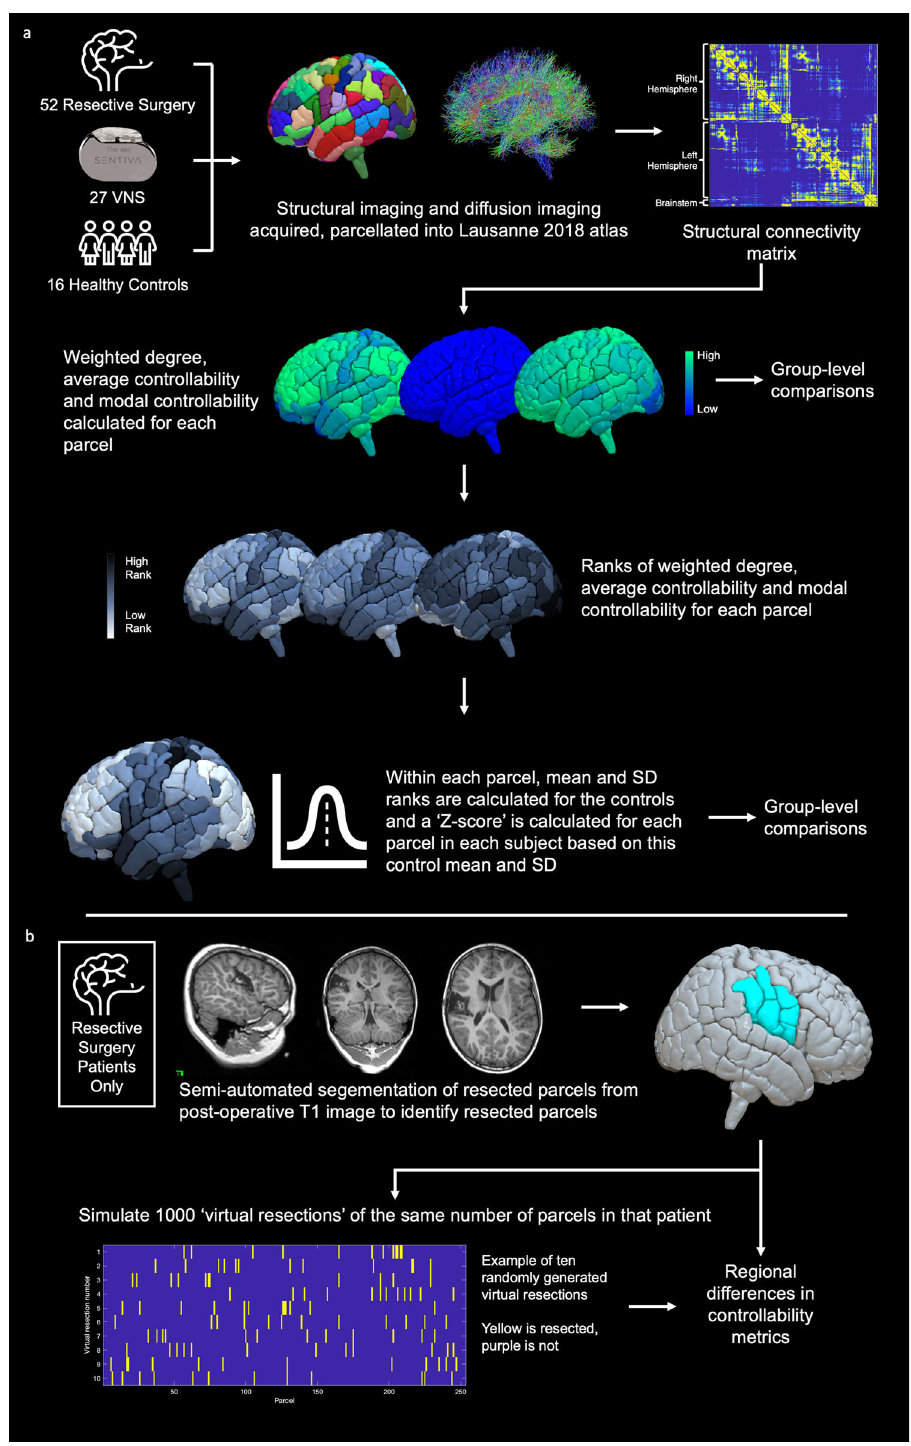
Fig. 7 Summary of image processing work fl ow. a Following subject identi fi cation, structural imaging was parcellated into Scale 3 of the Lausanne 2018 resulting in 253 parcels per patient. Structural connectivity matrices were generated for each patient where the connection strength was derived from the number of streamlines between each of the 253 parcels. Using these matrices, the weighted degree, average controllability and modal controllability were calculated for each parcel, which were subsequently ranked within each subject and normalised based on the mean and standard deviation of the ranks in the healthy control subjects. b For the resective surgery cohort, resection volumes were mapped to the pre-operative parcellation to identify resected parcels. In order to robustly assess any regional differences, 1000 virtual resections of the same number of parcels as the actual resection were also mapped for each